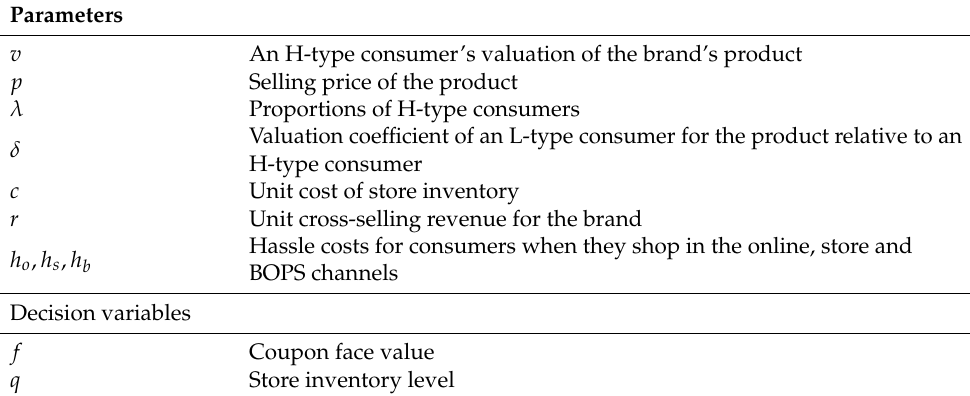
Table 1. Summary of